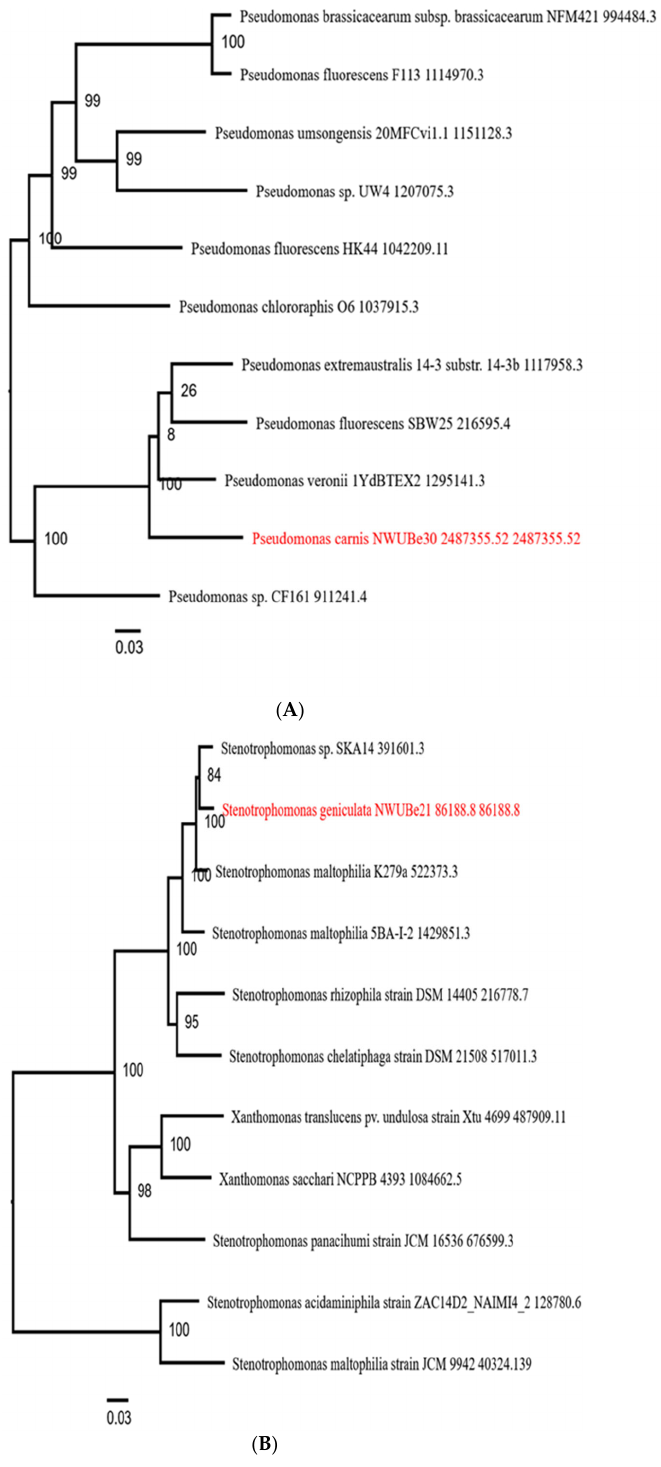
Figure 2. ( A ) Phylogenetic relatedness of endophytic Pseudomonas carnis strain NWUBe30 with other isolates in GenBank. ( B ) Phylogenetic relatedness of endophytic Stenotrophomonas geniculata strain NWUBe21 with other isolates in GenBank. Table 1. Growth promoting in vitro and biochemical attributes of the endophytic bacteria P. carnis NWUBe30 and S. geniculata NWU Be21 strains.